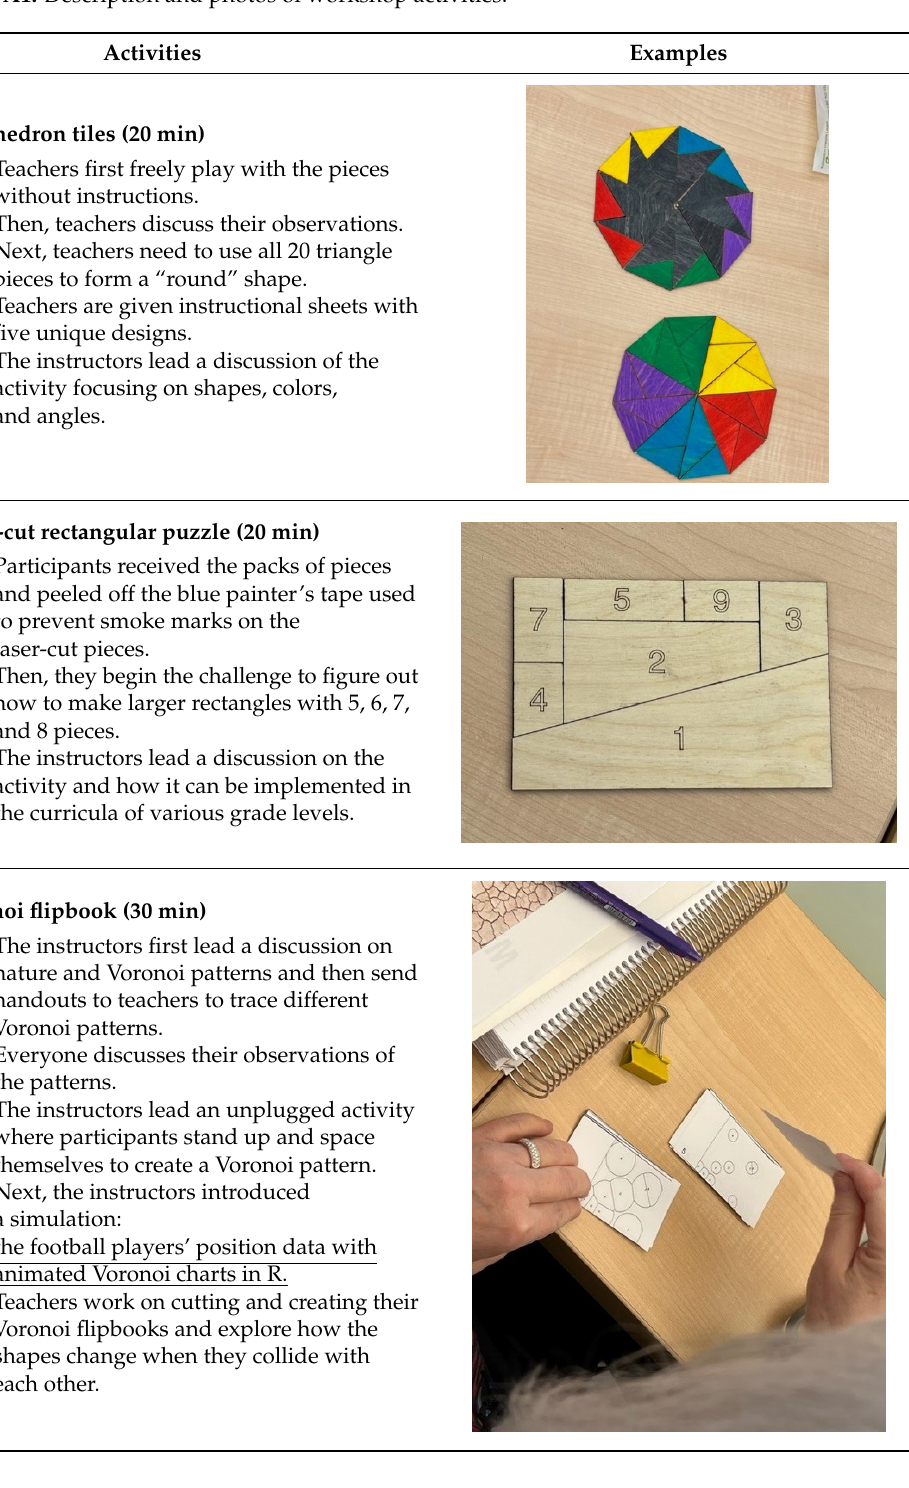
Table A1. Description and photos of workshop